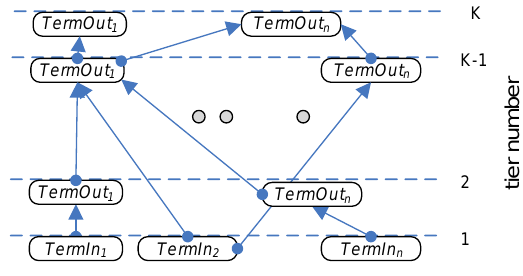
Fig. 3. Module term connectivity